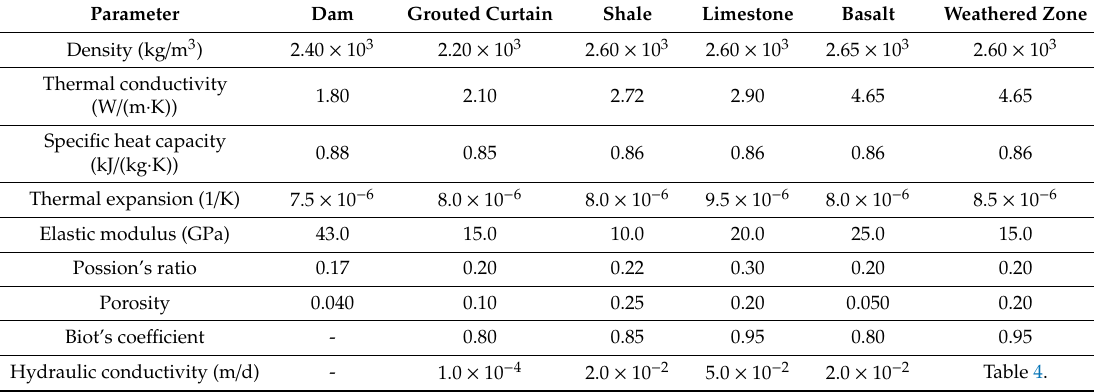
Table 3. Material parameters of the finite element method (FEM) model.